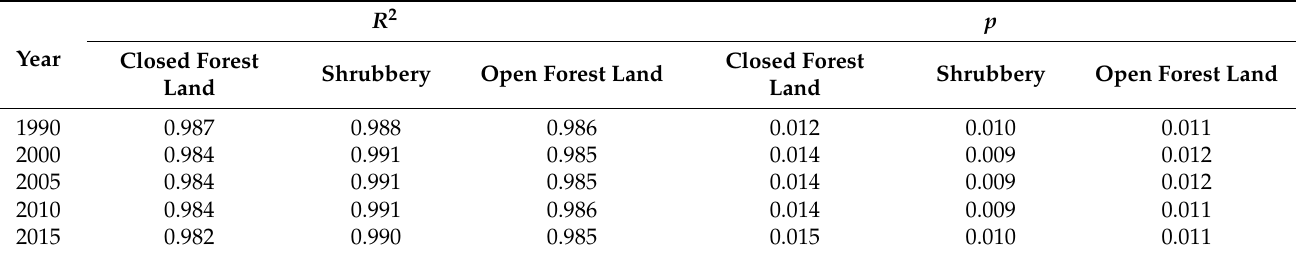
Table 2. Regression analysis on slope element and distribution of three types of forest landscape. R 2 p Year Closed